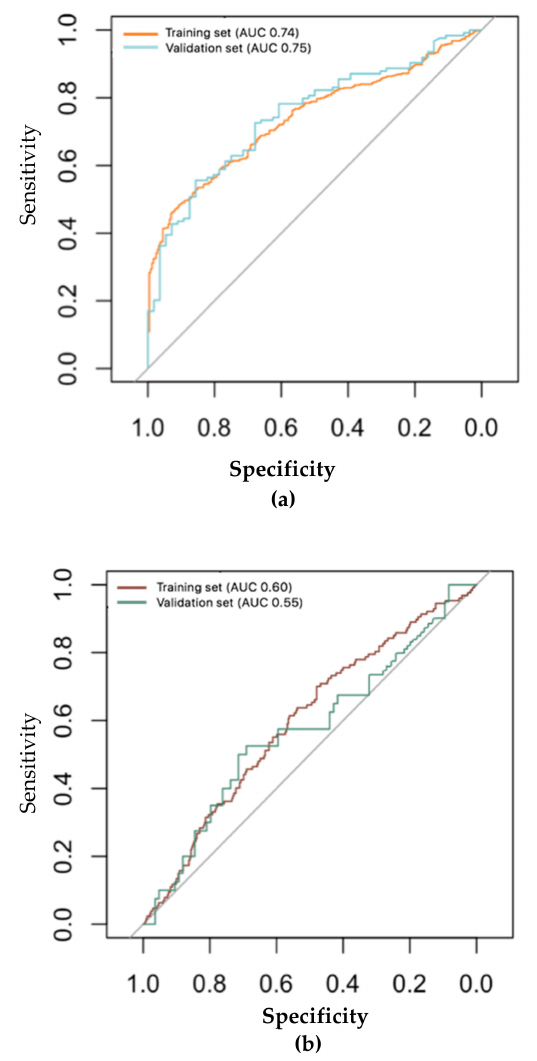
Figure 2. ROC analyses showing the accuracy of the linear discriminant model based on principal component (PC) reduction in the training set and the independent validation set for the asthma and COPD group. ( a ) Ever-smokers with asthma and COPD: training set (n = 469) 95% CI: 0.70–0.77 area under curve (AUC): 0.74; validation set (n = 124) 95% CI: 0.68–0.82 AUC: 0.75. ( b ) Time of last cigarette assumption in asthma and COPD patients (control: more than 24 h; case: less than 24 h): training set case = 127; control = 583; 95% CI: 0.54–0.65; AUC: 0.60; validation set case = 40; control = 84; 95% CI: 0.44–0.67; AUC: